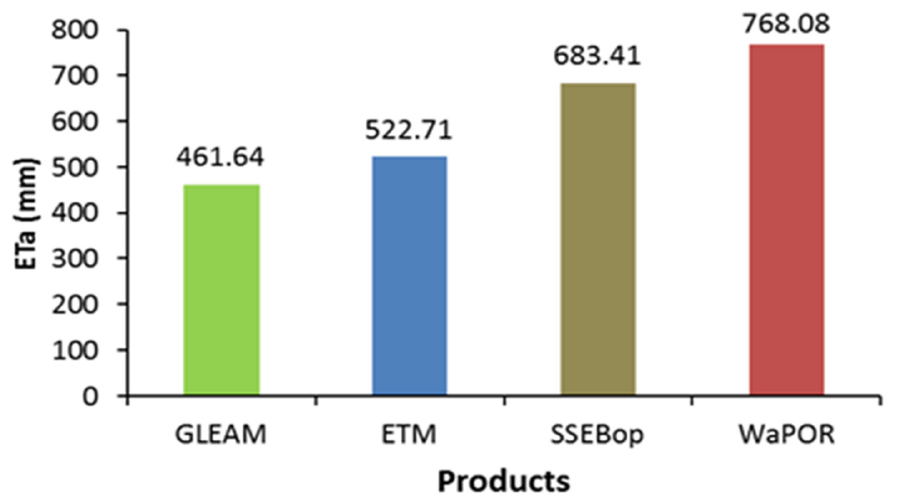
Figure A2. The annual mean of different remote sensing evapotranspiration products in Lake Chad.